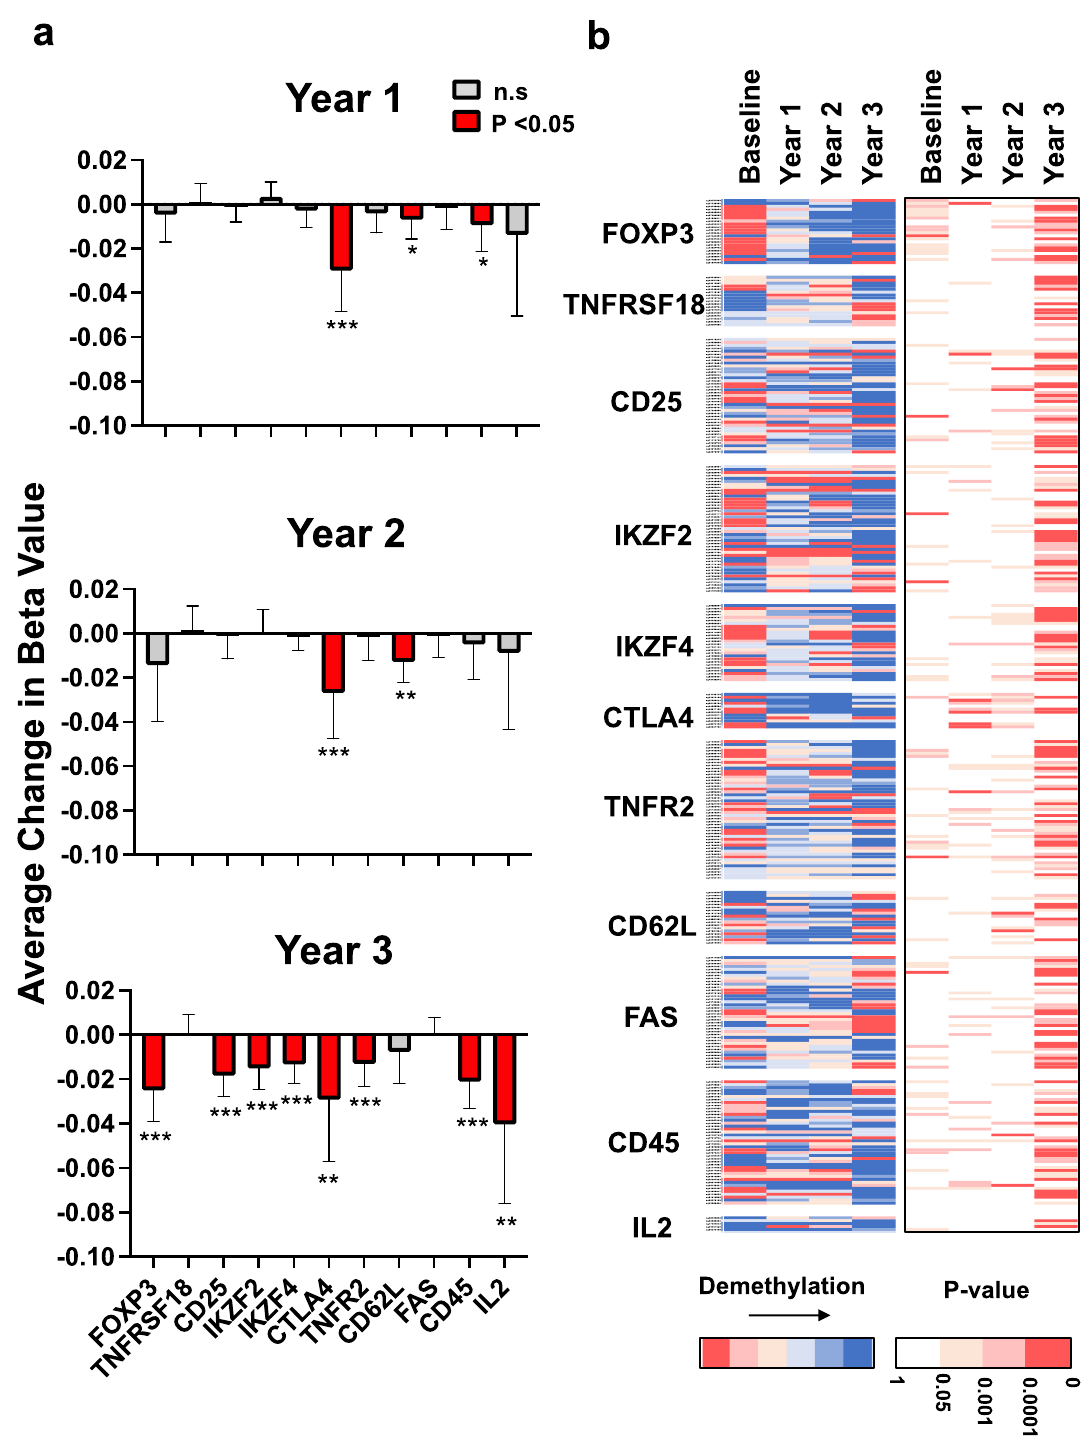
Figure 1. Most Treg signature genes gradually demethylate over a three year time course after in vivo BCG vaccinations. Methylation changes in eleven well-known Treg signature genes were quantified yearly after multi-dose BCG vaccine therapy (n = 13 type 1 diabetic subjects). ( a ) The methylation values are current methylation values at year 1, year 2 or year 3 compared to baseline expressed as average change in beta values. Positive beta values indicate increased methylation and thus decreased gene expression; negative methylation values indicate demethylation and increased gene expression. Significant decreases in methylation after BCG were seen in eight of 11 genes: FOXP3, CD25, IKZF2, IKZF4, CTLA4, TNFR2, CD62L, CD45 and IL2 (p value < 0.05: *; p value < 0.01: **; p value < 0.001: ***). Red bars represent statistically significant change in methylation. ( b ) The left heatmap shows average difference in beta values for individual Illumina CG Identifiers (CGs) of the Treg signature genes at yearly intervals. Increased blue coloration in the heat map means increased demethylation of the CpG sites within a Treg signature gene. The right heatmap indicates the p-values in the corresponding CpG sites; Blank and red indicate without or with significance, respectively, and degree of red color reflects the strength of significance. In the both heatmaps each individual CpG gene site is represented as a single